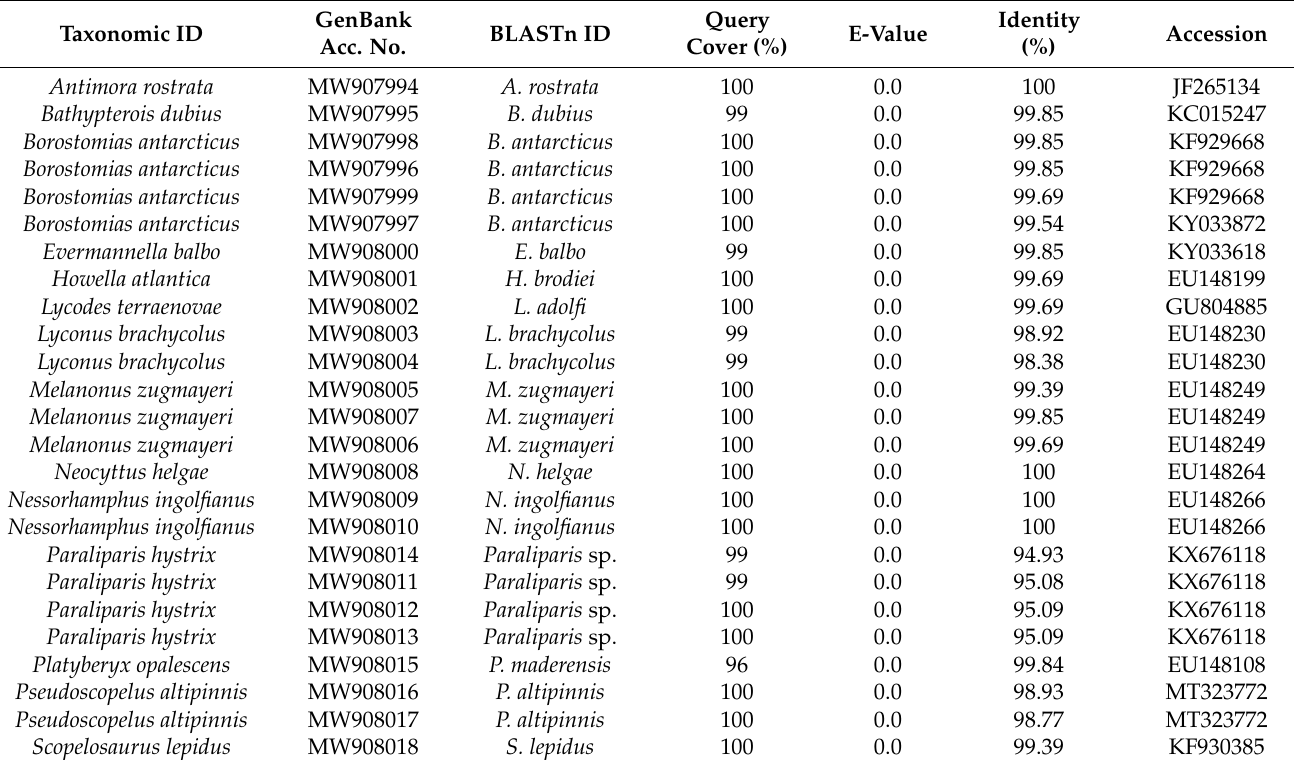
Table 1. Top total score BLASTn identification results of COI